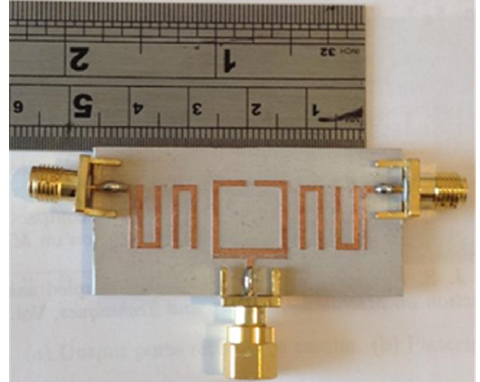
Figure 6. Photograph of the fabricated microstrip filtering power splitter.